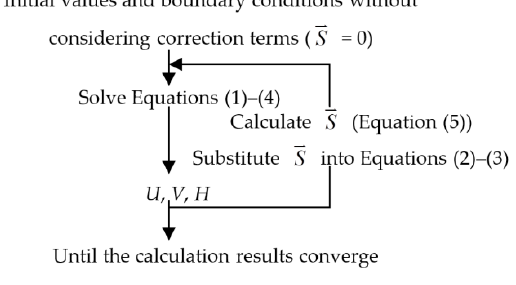
Figure 1. Solution procedure.